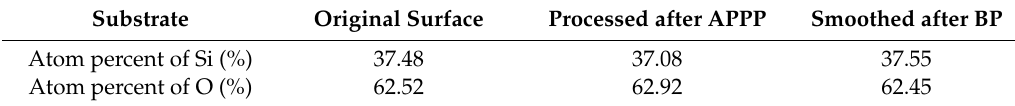
Figure 13. The energy dispersive spectroscopy on different substrate surfaces. ( a ) Original surface; ( b ) Processed after APPP and ( c ) Smoothed after BP. Table 4. Chemical component on different substrate surfaces.